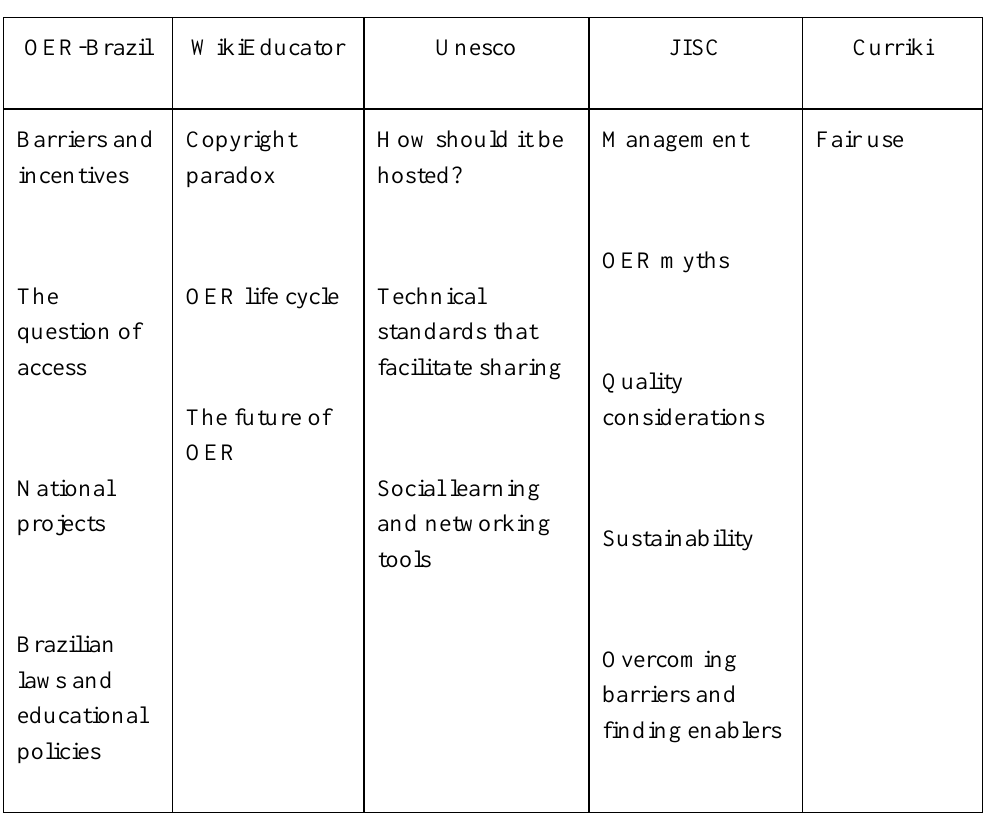
Exclusive Topics from each